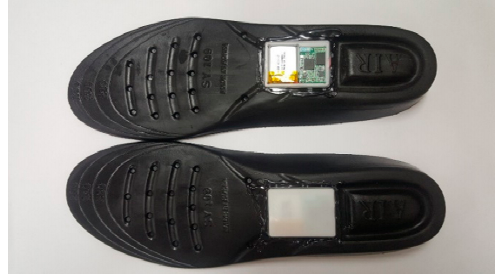
Figure 2. Sensor attachments to the insoles.